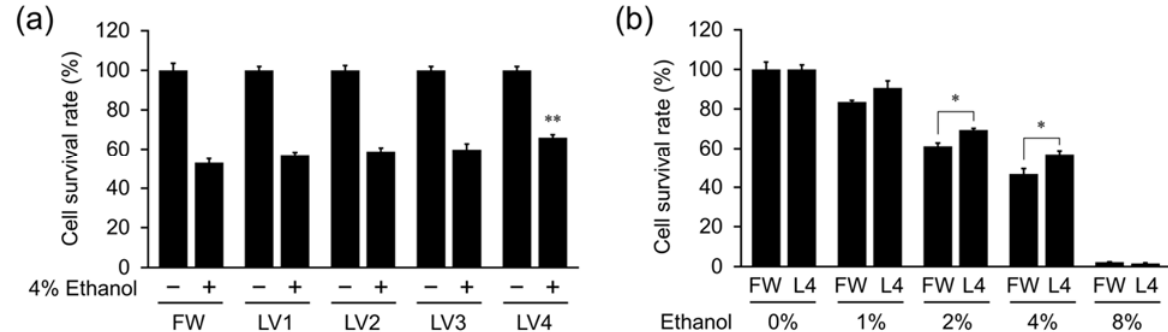
Figure 2. Measurement of cell viability of HepG2 following ethanol—EHW co-treatment. The cell survival rate of HepG2 cells were measured by the trypan blue method after culture in a medium prepared using filtered water (FW) or EHW of different grades (LV1–4), prepared using different electric currents (0.8–4.2 A) and then subjected to 4% ethanol ( a ), and FW or EHW LV4 containing different concentrations ethanol ( b ). The cells were incubated for 24 h following ethanol treatment. The data represent the mean ± SEM ( n = 3). Asterisks indicate significant difference analyzed with Dunnett’s test, ** p < 0.01 vs. FW as a control among the 4% ethanol treatment groups ( a ), or Student’s t -test, * p < 0.05 vs. FW at different concentrations ethanol ( b ).